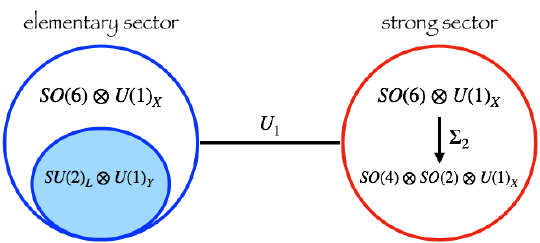
Figure 1 . The 2-site construction in the gauge sector based on the SO(6) = SO(4) (cid:2) SO(2) coset. The (cid:12)rst site is the elementary sector while the second one is the composite sector with SO(6) (cid:2) U(1) X heavy